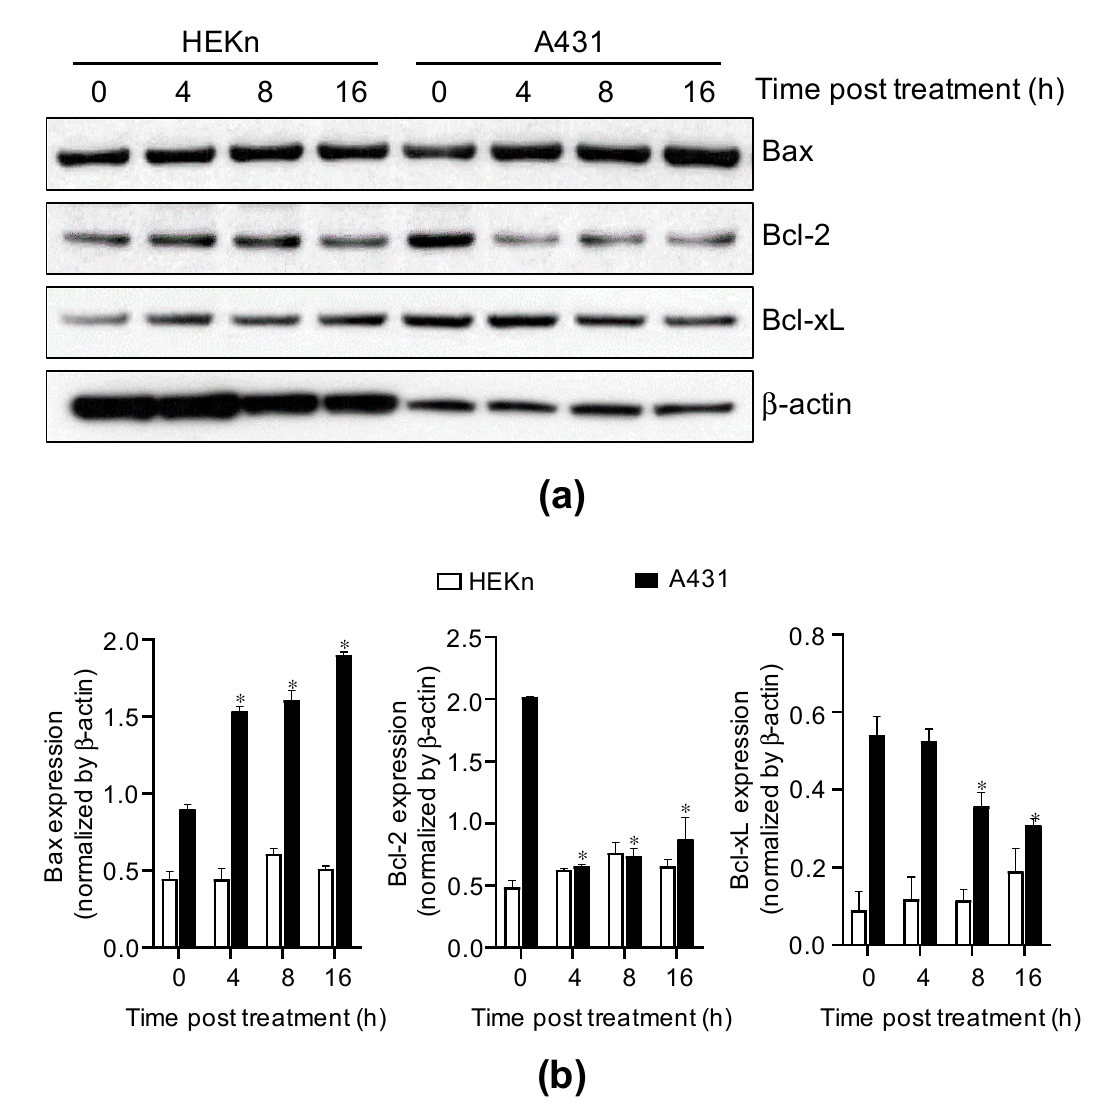
Figure 3. Effect of costunolide on the expression of Bcl-2 family members in HEKn cells and A431 cells. HEKn cells and A431 cells were treated with costunolide (0.8 µ M) at various time points (0, 4, 8, and 16 h). Whole cell lysates were harvested. ( a ) Protein levels of the Bcl-2 family (Bax, Bcl-2, and Bcl-xL) members were evaluated by western blotting. β -actin was used as the loading control. ( b ) Bar graphs display quantification of protein levels normalized by β -actin. * p < 0.05 as compared to vehicle-treated group.